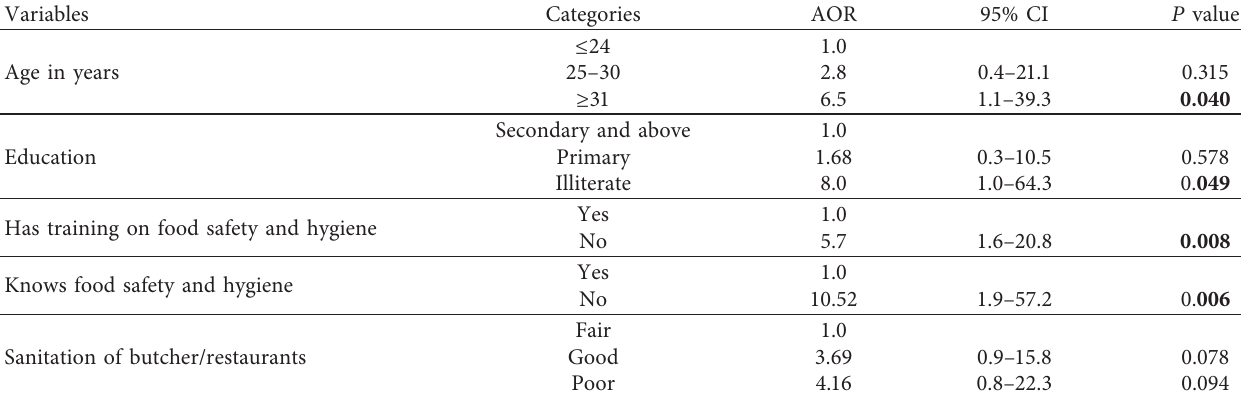
Table 8: Multivariable logistic regression analysis of factors associated with the contamination of meat with Salmonella in Ambo and Holeta towns, central Ethiopia.